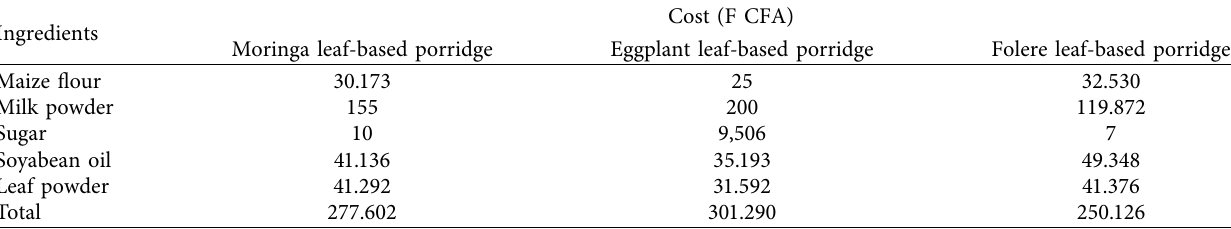
Table 4: Cost contribution of each ingredient to the total cost of each porridge.